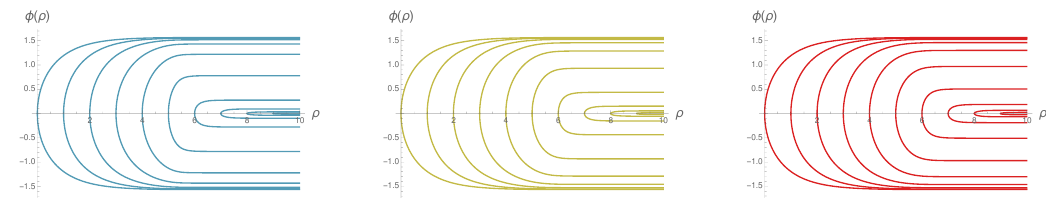
Figure 7 . Extremal surfaces in AdS 5 → AdS 3 × T 2 flow solutions of figure 6, in corresponding colors (from left to right for ( a 1 , a 2 ) ∈ { (1 , 2) , (3 , 4) , (3 , 3) }